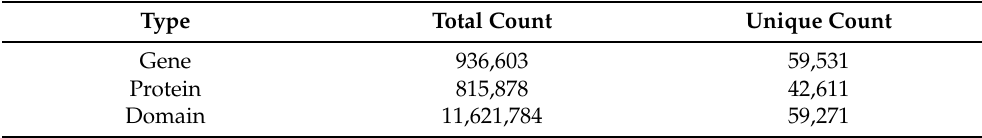
Table 2. Observed gene, protein, and functional domain biological entities in total count (redundant) and unique sequences (distinct) in high quality